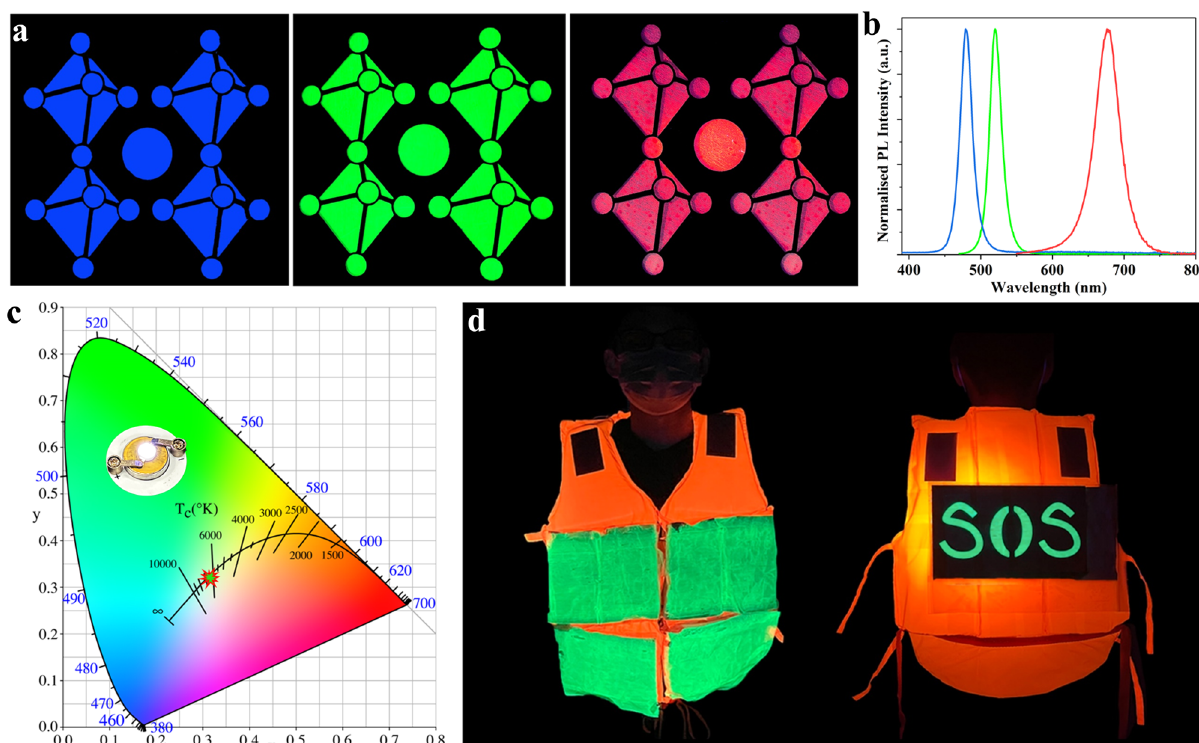
Fig. 4 | Applications of PLTs in patterned display, WLEDs and wearable lumi- nescent clothes. a Patterned fl uorescent displays (10cm×10cm) and ( b ) their corresponding PL spectra of different colors (blue, green and red). c The 1931 CIE chromaticity coordinates of white LEDs fabricated with CsPbBr 3 @HPbCD@PFOS